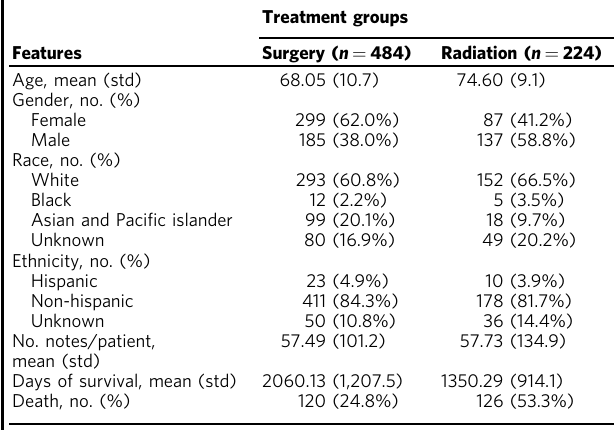
Table 2 Characteristics of the stage I lung cancer